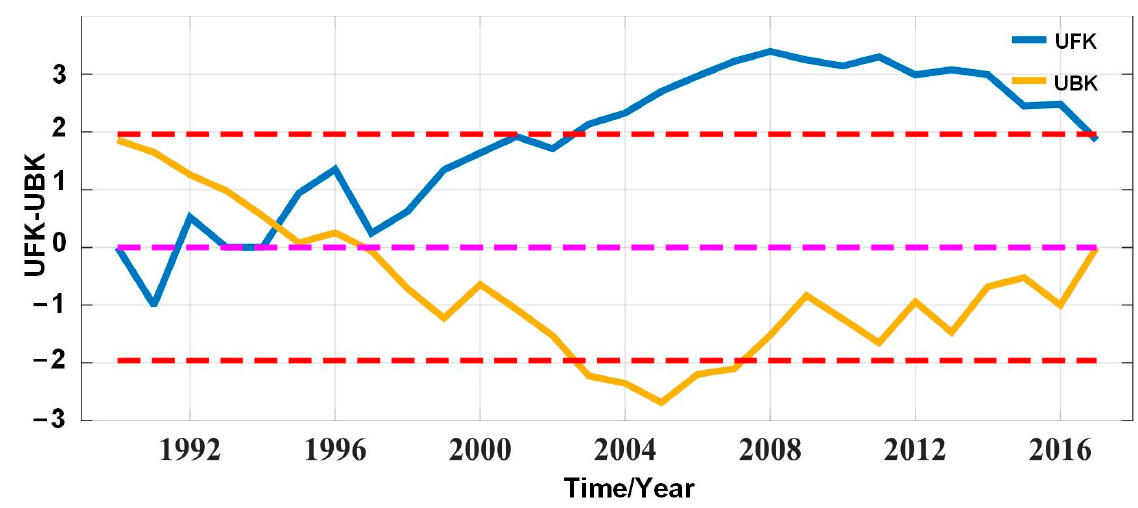
Figure 7. The MK test of annual variation of WPD in the South China Sea.